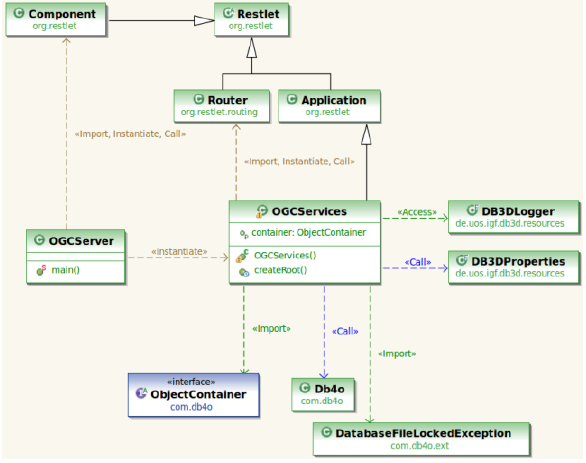
Figure 3: Connection of the classes OGCServer and OGCServices between RESTlet and db4o